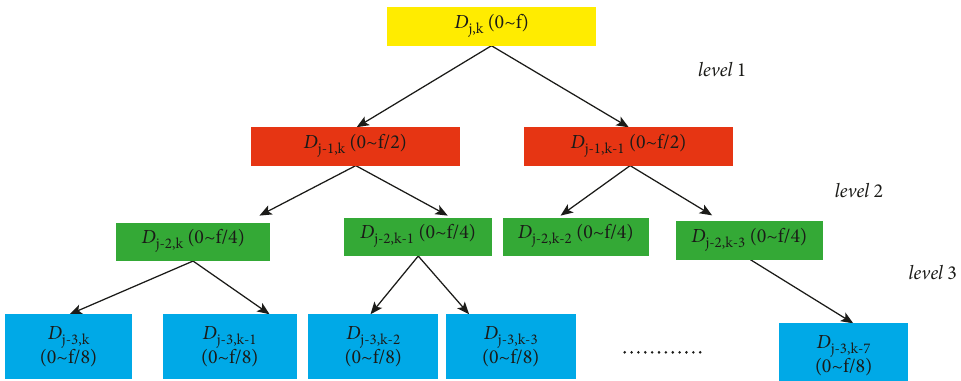
Figure 1: Schematic diagram of wavelet packet